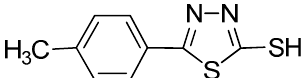
Figure 1. Structure of inhibitor molecule.